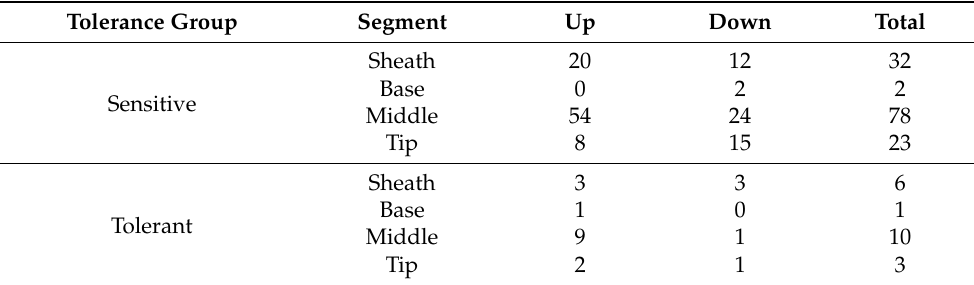
Figure 7. Principle component analysis of RNA-Seq raw counts from leaf segments samples exposed to control and HNT conditions separated for sheath ( A ), base ( B ), middle ( C ) and tip ( D ). PCA is as in Figure 6, with HNT and control color-coded and HNT sensitivity of cultivars marked with specific symbols. Table 2. Overlap of significant differentially expressed genes between the approaches DESeq2 (FDR < 0.1; |log2FC| ≥ 1) and edgeR (FDR < 0.05; |log2FC| ≥ 1) for rice leaf segments upon HNT stress. Three cultivars each were analyzed for the sensitive (M202, CT9993-5-10-1M, IR62266-42-6-2) and the tolerant (IR67311, IR72, Nipponbare)